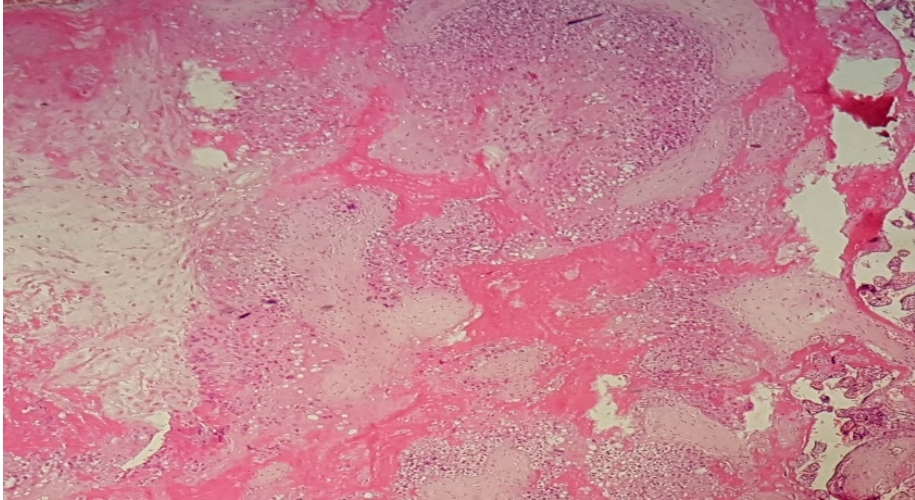
Figure 3. (Haematoxylin–eosin 10×). Extensive decidual ischemic changes and infarction with important fibrin deposition and inflammatory changes.